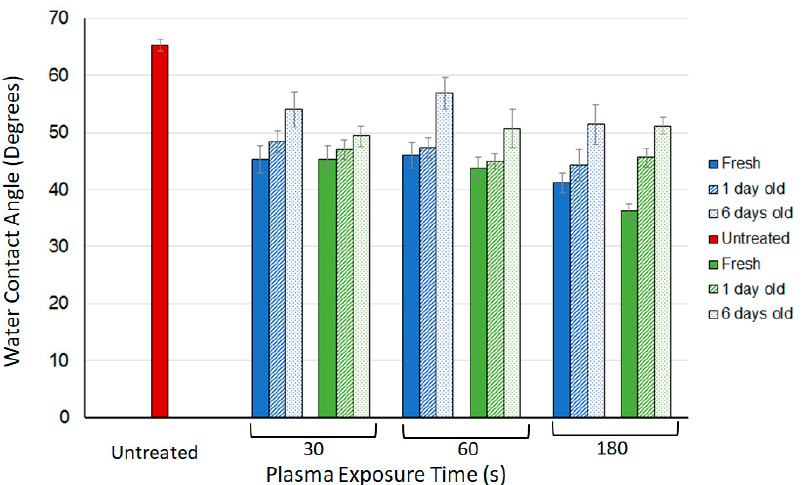
Figure 7. WCA measurements of He/O 2 (blue) and He/H 2 O (green) plasma-treated nylon films with treatment times of 30, 60, and 180 s, respectively. The untreated pristine nylon film is shown in red for comparison.